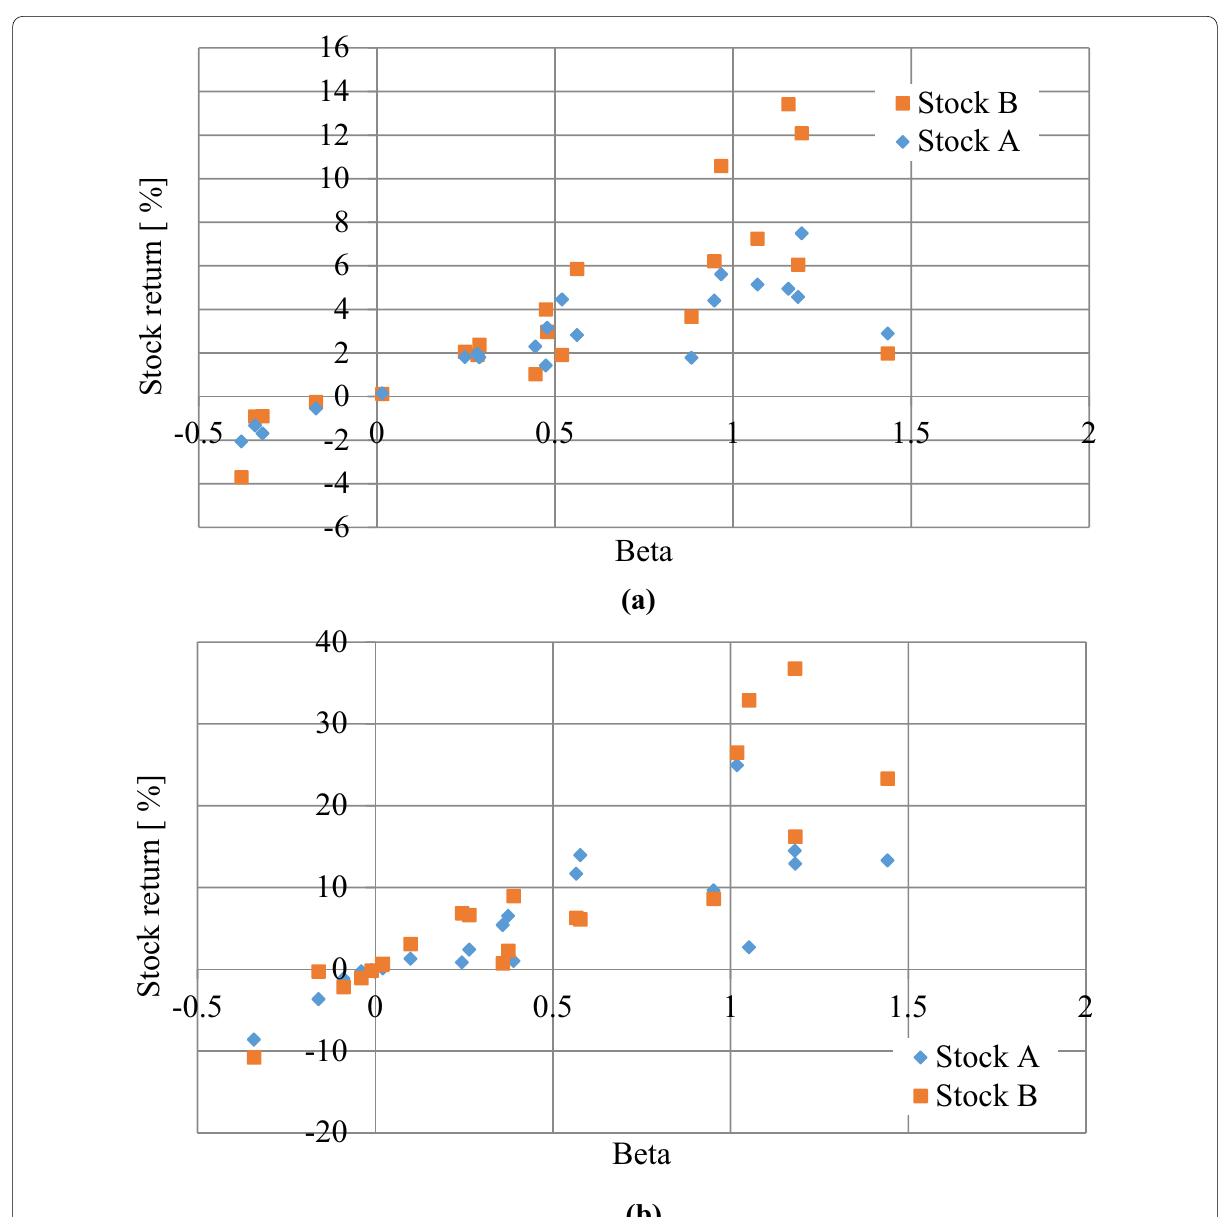
Fig. 14 Security market line of stock A and stock B with varying beta and market returns on a S&P 500, b BSE